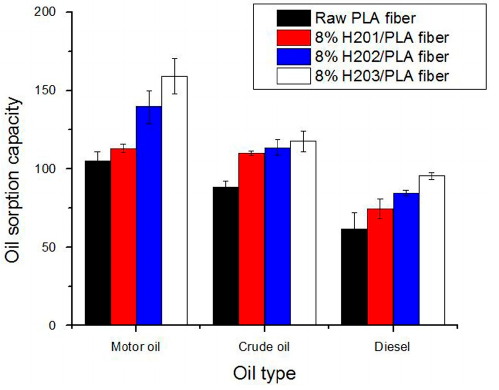
Figure 6. Oil sorption capacity of melt electrospun fibers for different types of oil.